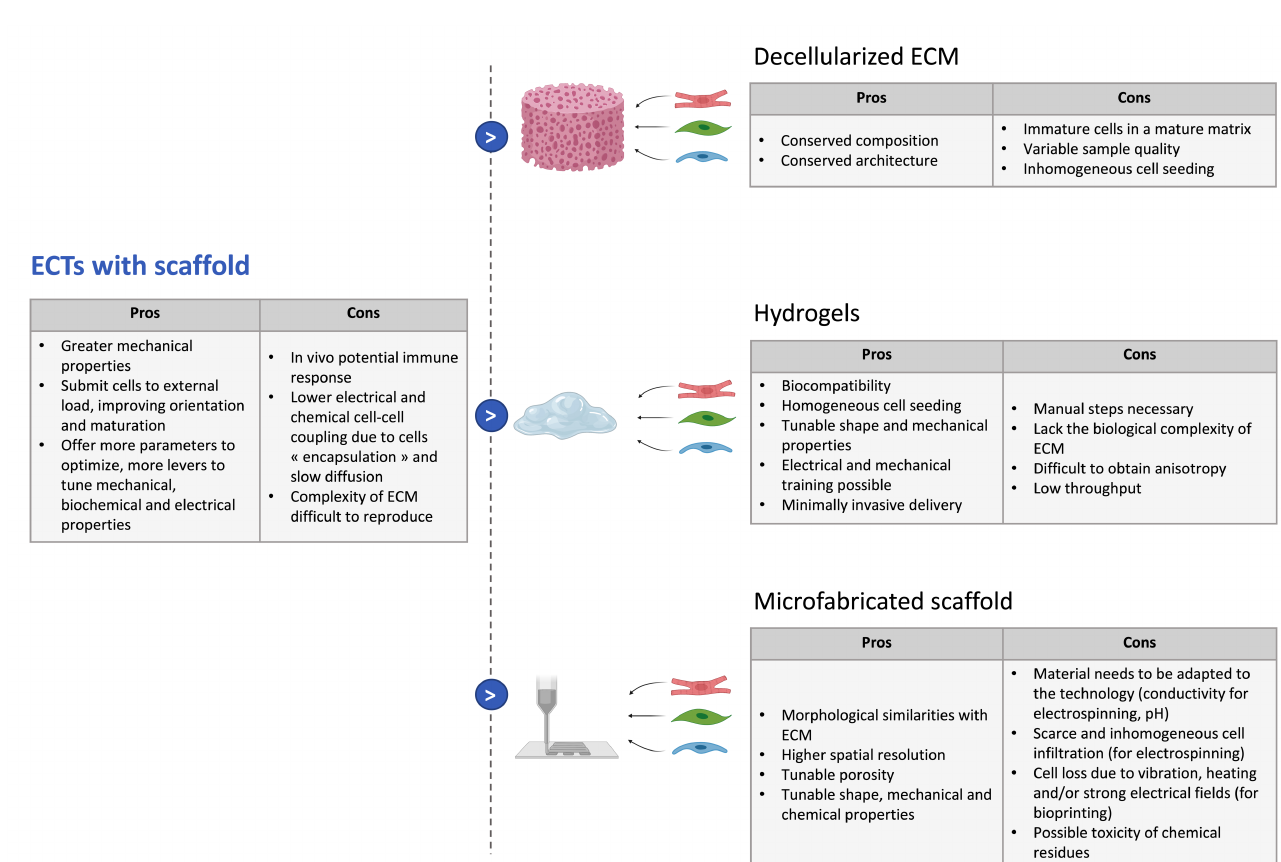
Figure 2. Strategies to build 3D-ECTs with scaffolds, advantages, and